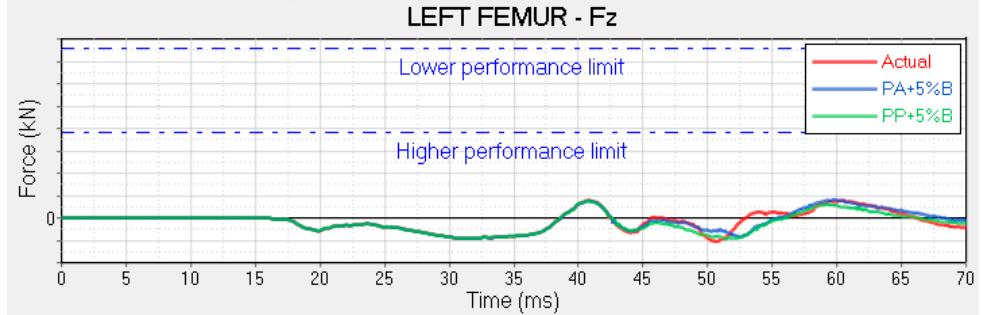
Figure 8. Load on the left femur.